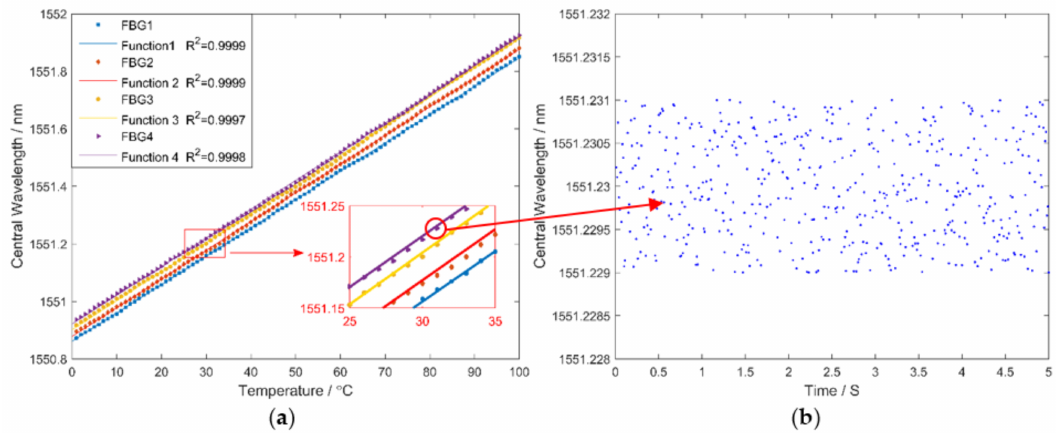
Figure 12. The relationship between central wavelengths and temperature: ( a ) central wavelengths of FBG sensors under different temperature; and ( b ) the measurement result when temperature is